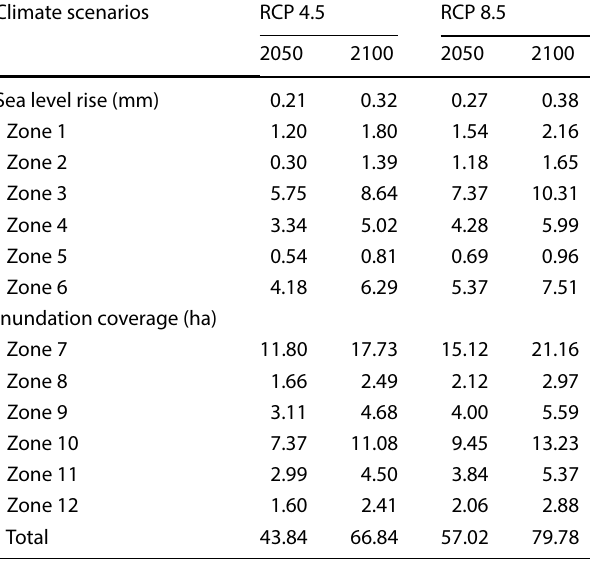
Table 7 The projected sea level rises and inundated areas for each zone at Marudu Bay Climate scenarios